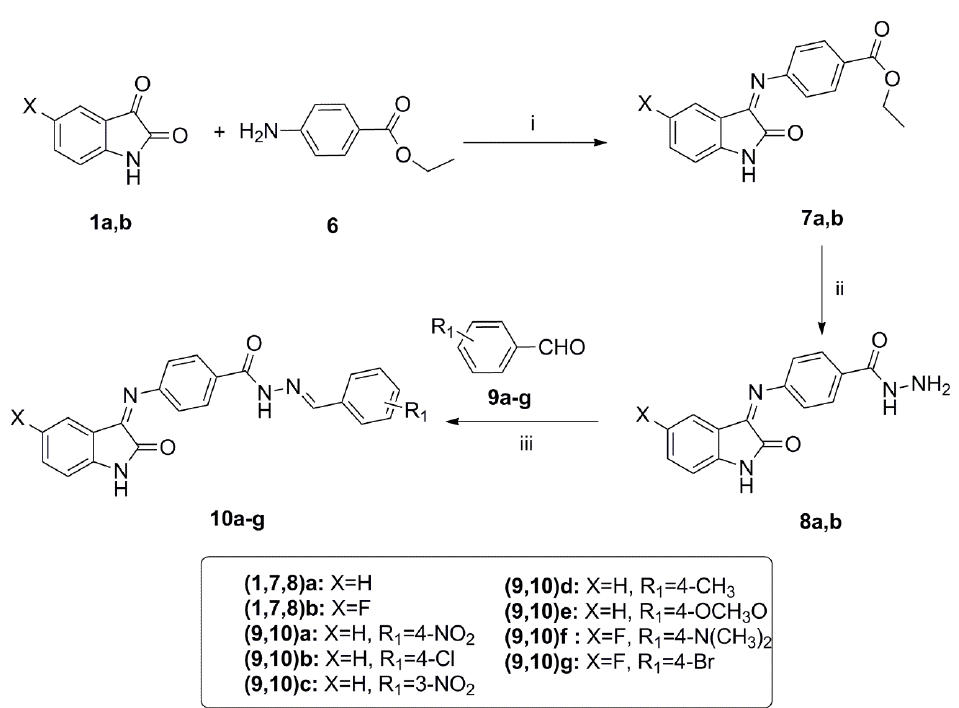
Scheme 1. Synthesis of the target compounds 3a , b – 5a , b . Reagent and conditions: ( i ) EtOH, AcOH, Reflux, 4 h; ( ii ) EDC, Et 3 N, HOBT, DMF, 0 °C to rt, overnight.